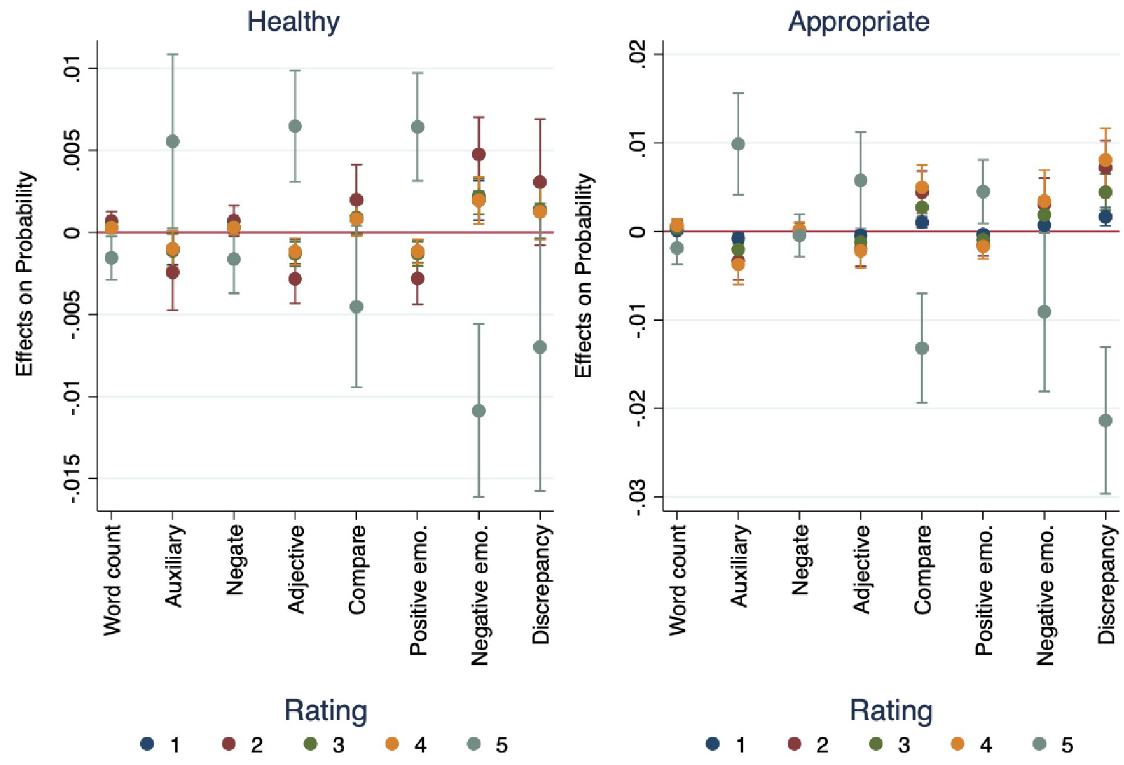
Fig 8. Marginal effects language use on probability of rating audio samples as healthy and